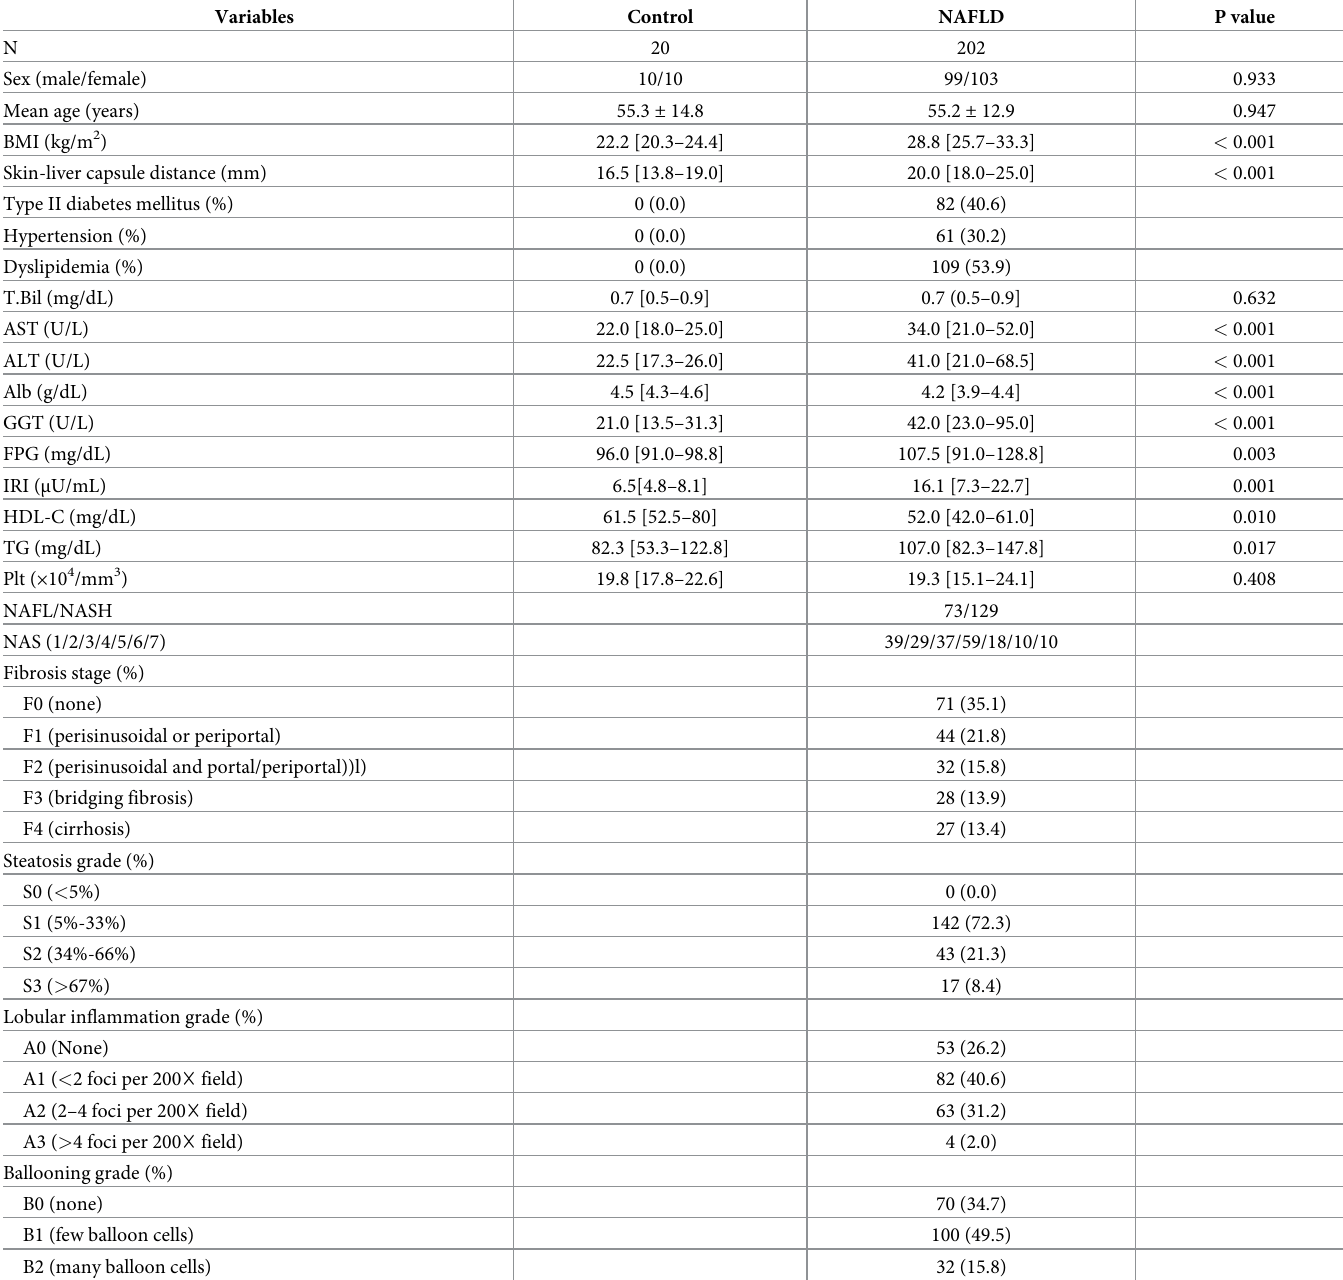
Table 1. Baseline characteristics of control participants and patients with